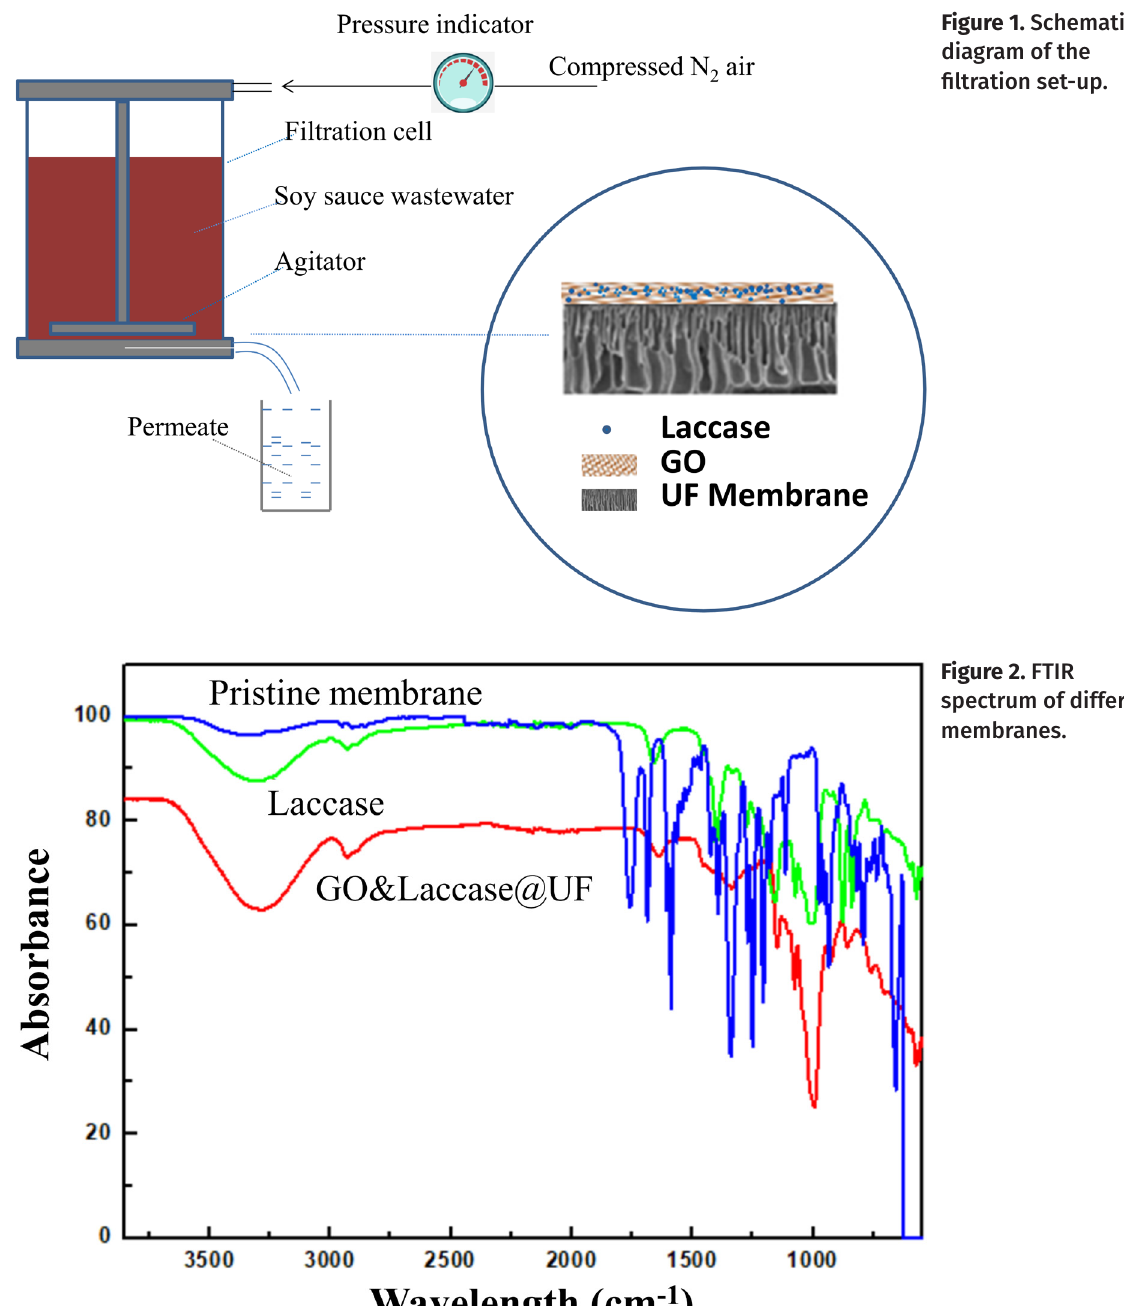
Figure 1. Schematic diagram of the filtration set-up.